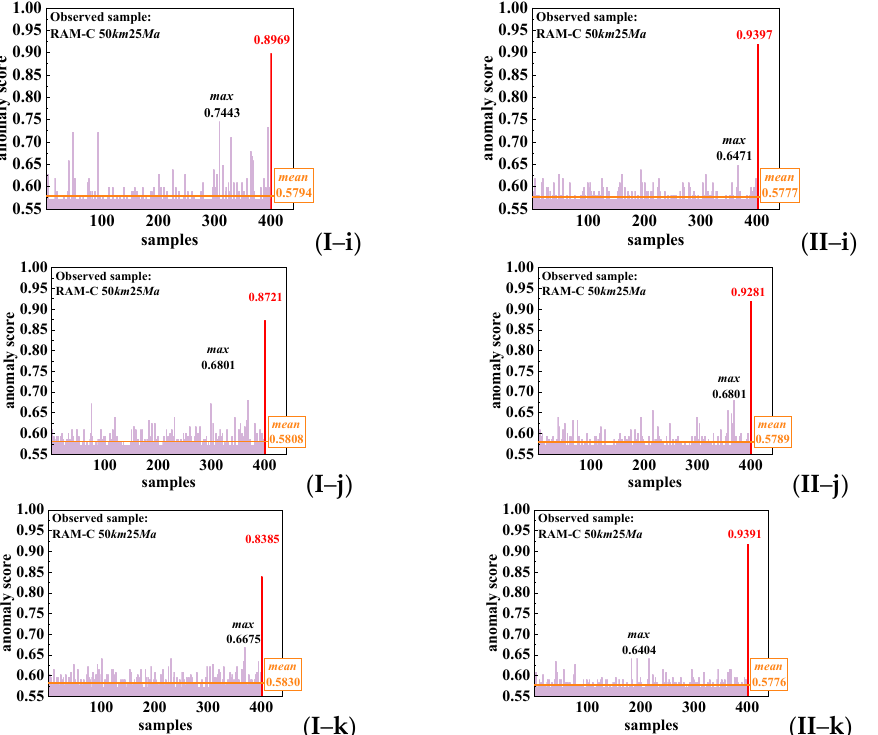
Figure 13. Anomaly scores of subclasses and data streaming under different value of N f and N t . ( I ) AHFNS. ( II ) AHFS. ( a ) N f = 1, N t = 1. ( b ) N f = 2, N t = 1. ( c ) N f = 3, N t = 1. ( d ) N f = 4, N t = 1. ( e ) N f = 5, N t = 1. ( f ) N f = 6, N t = 1. ( g ) N f = 1, N t = 2. ( h ) N f = 1, N t = 3. ( i ) N f = 1, N t = 4. ( j ) N f = 1, N t = 5. ( k ) N f = 1, N t